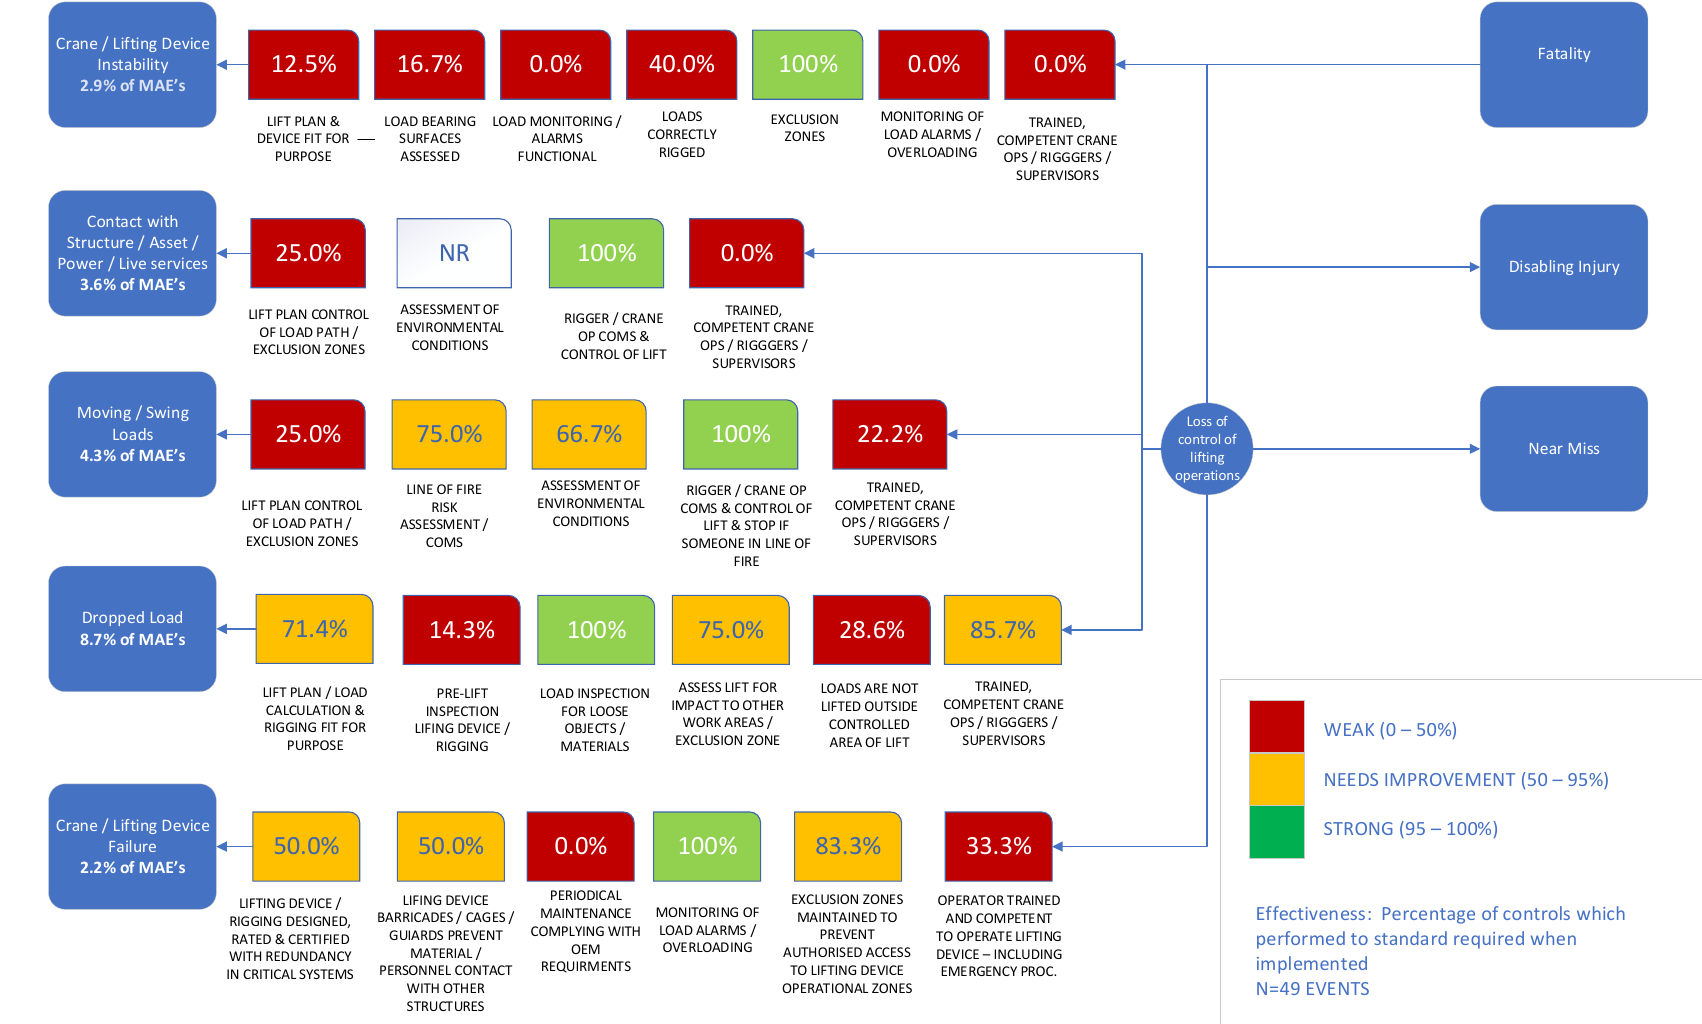
Figure 8. Lifting Operations—Critical Control Reliability.